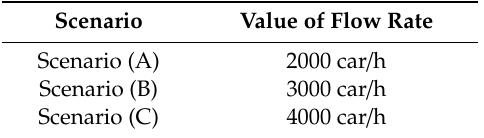
Table 4. Specifications of the three considered scenarios.